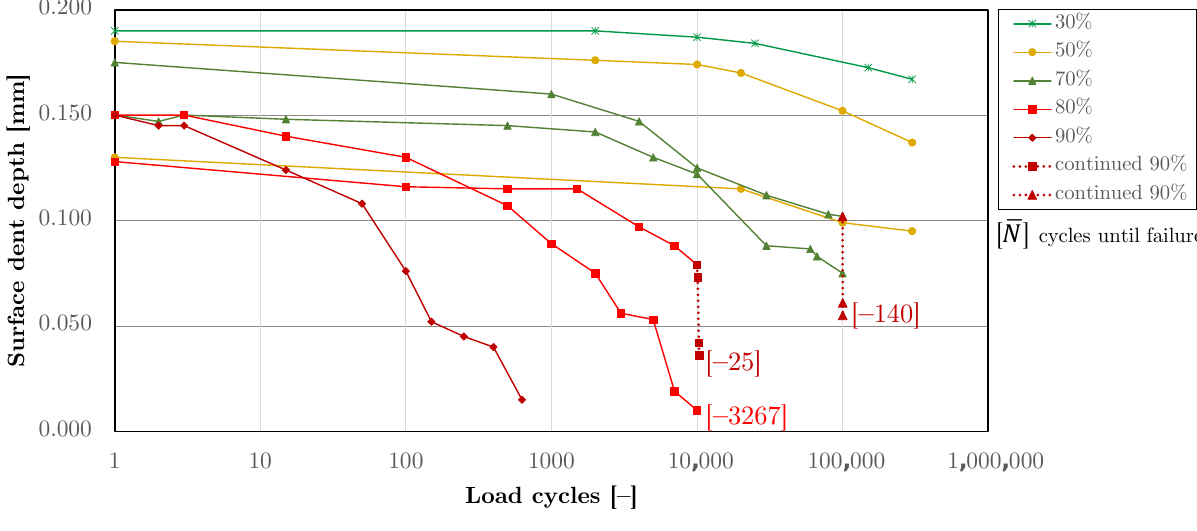
Figure 10. Relaxation of the dent depth at the impact spot depending on the cyclic load. ¯ N represents the number of cycles until ultimate failure under cyclic load for the specimens